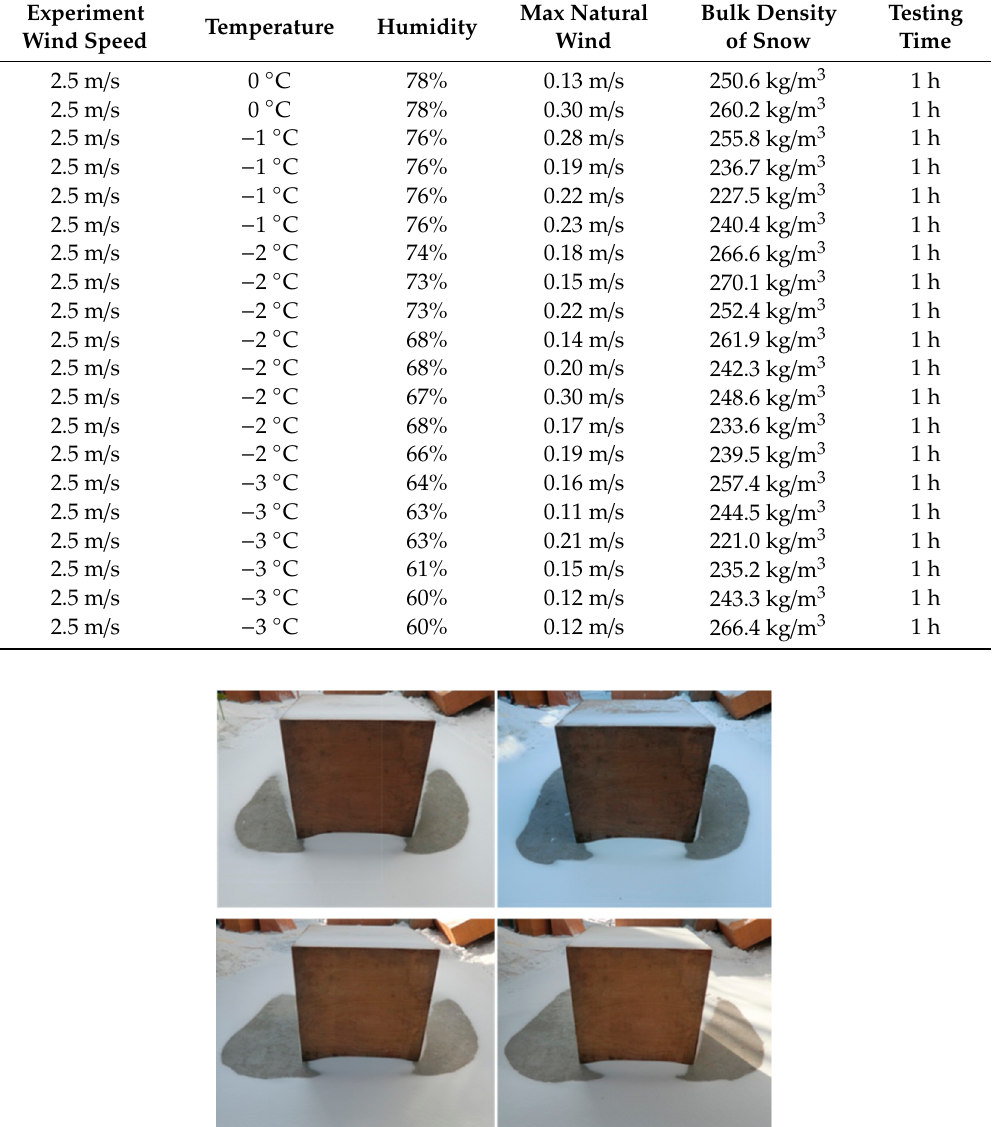
Table 2. Environmental conditions of the 20 repetitive experiments.